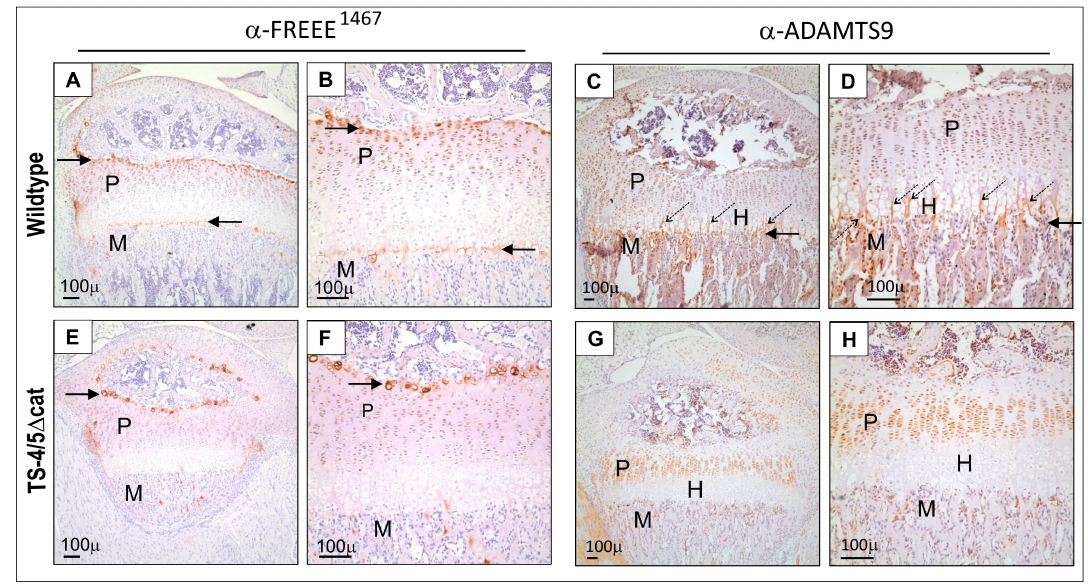
Figure 5. ADAMTS-9 protein and FREEE 1467 neoepitope are present in the 3-week-old mouse joint. M, metaphysis; P, proliferative zone of the growth plate; left-pointing arrow, metaphyseal border; right-pointing arrow, boundary of the secondary centre of ossification; diagonal dotted arrows, columns of calcified cartilage; H, hypertrophic zone of the growth plate. Panels ( a , b , e , f ) show staining for the FREEE 1467 neoepitope. Panels ( c , d , g , h ) show staining for ADAMTS-9 protein. Panels ( a – d ) show cartilage from wildtype mice. Panels ( e – h ) show cartilage from TS-4/5 Δ cat mice. Unlike the limited staining for the aggrecan FREEE 1467 neoepitope seen in wildtype growth plates (Figure 5 a,b,e,f), ADAMTS-9 immunostaining was strong throughout all zones of the wildtype growth plate, including the metaphysis (M), proliferative zone (P), hypertrophic zones (H) and in bony spicules ( diagonal dotted arrows ) protruding into the calcified region of the hypertrophic zone (Figure